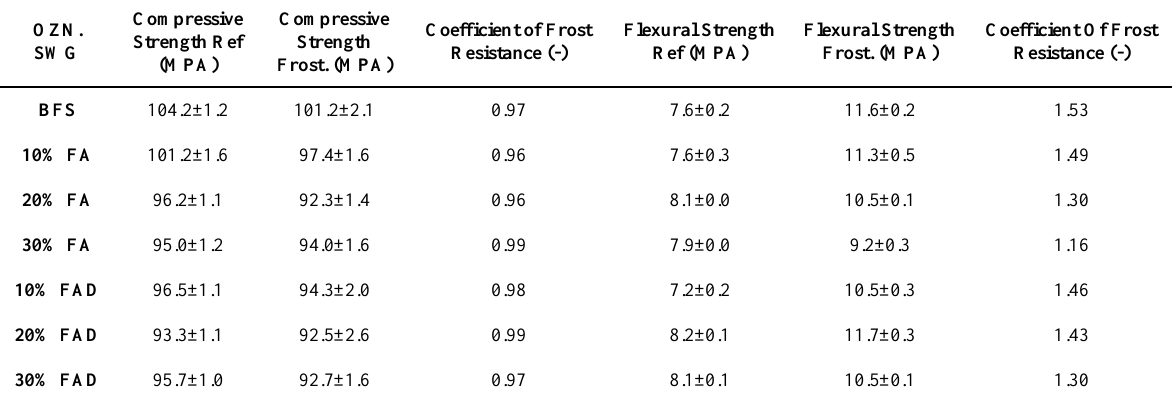
Table 5. Frost resistance